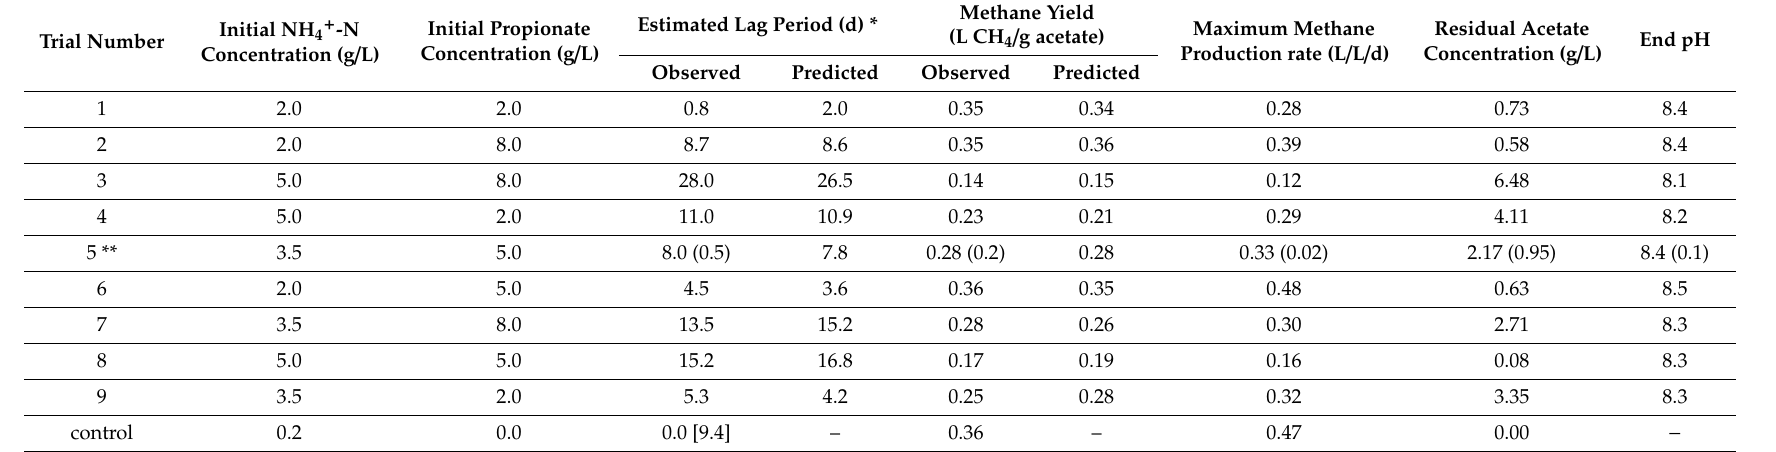
Table 1. Experimental design and results of acetate-utilizing methanogenesis at di ff erent